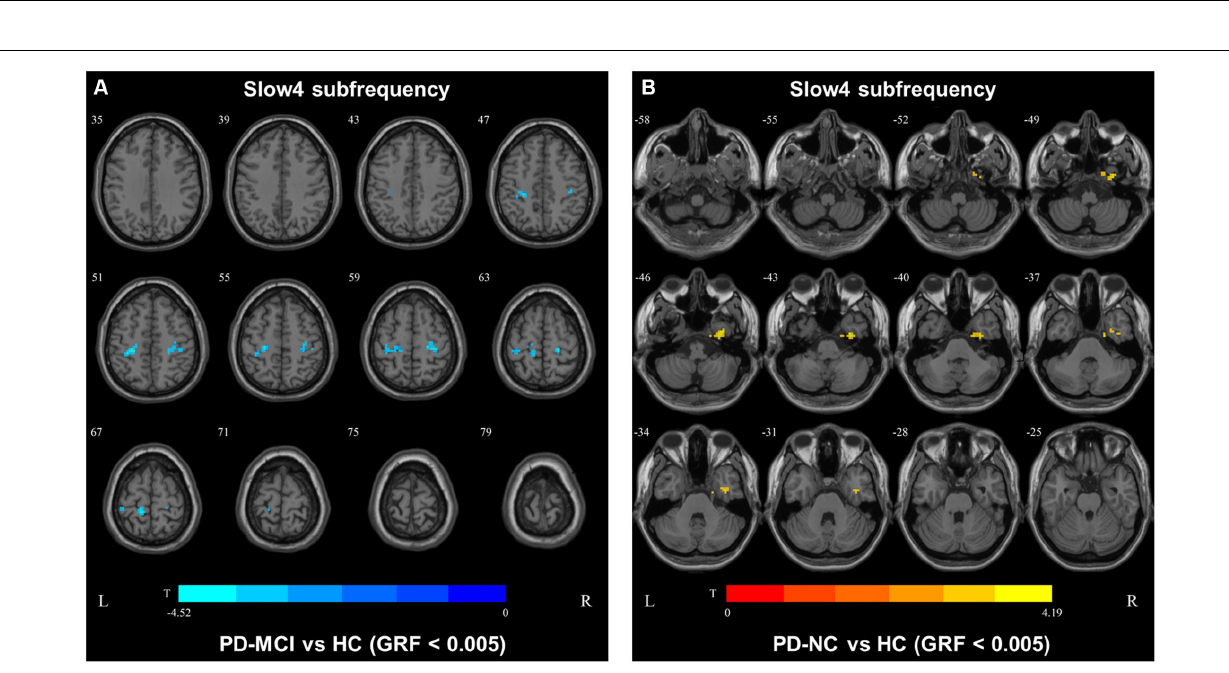
between the PD-MCI and PD-NC groups. The DC value in the slow5 band was more effective and reliable for distinguishing PD-MCI from PD-NC than that in the conventional and